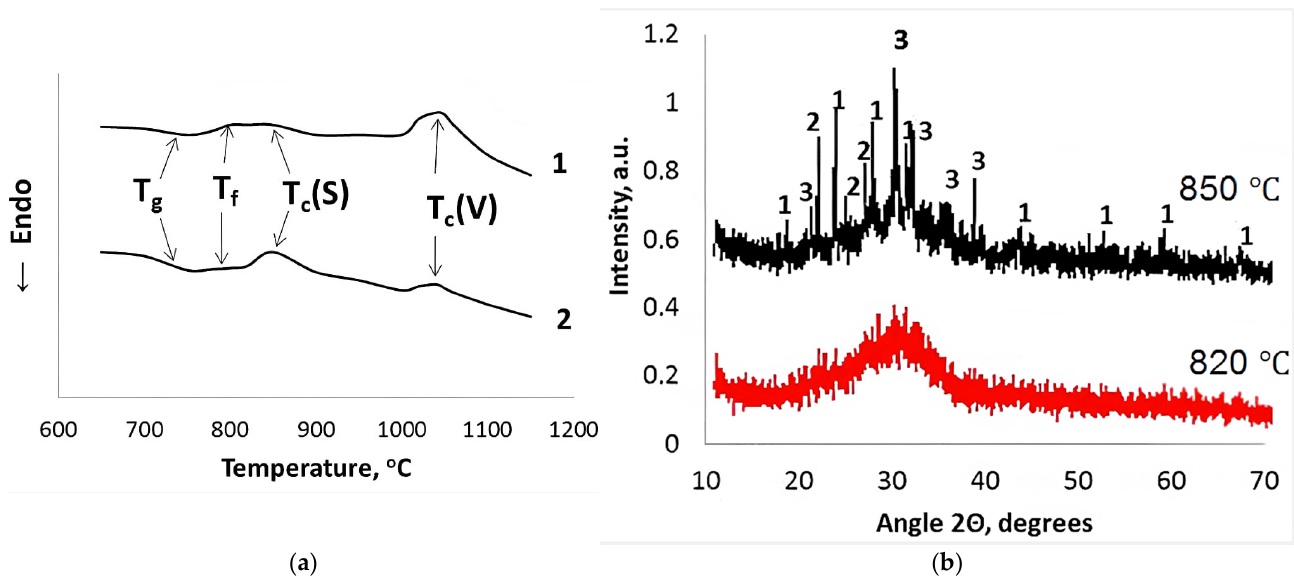
Figure 1. DSC data obtained for the coarse (1) and thin (2) powders of glass frit ( a ) and XRD patterns of the coarse glass powder fired at 820 and 850 °C ( b ). 1—nepheline, 2—gehlenite, 3—pyroxene. T g , T f , T c (S) and T c (V)–the temperatures of glass transition, fluidization, surface and bulk crystallization, respectively.